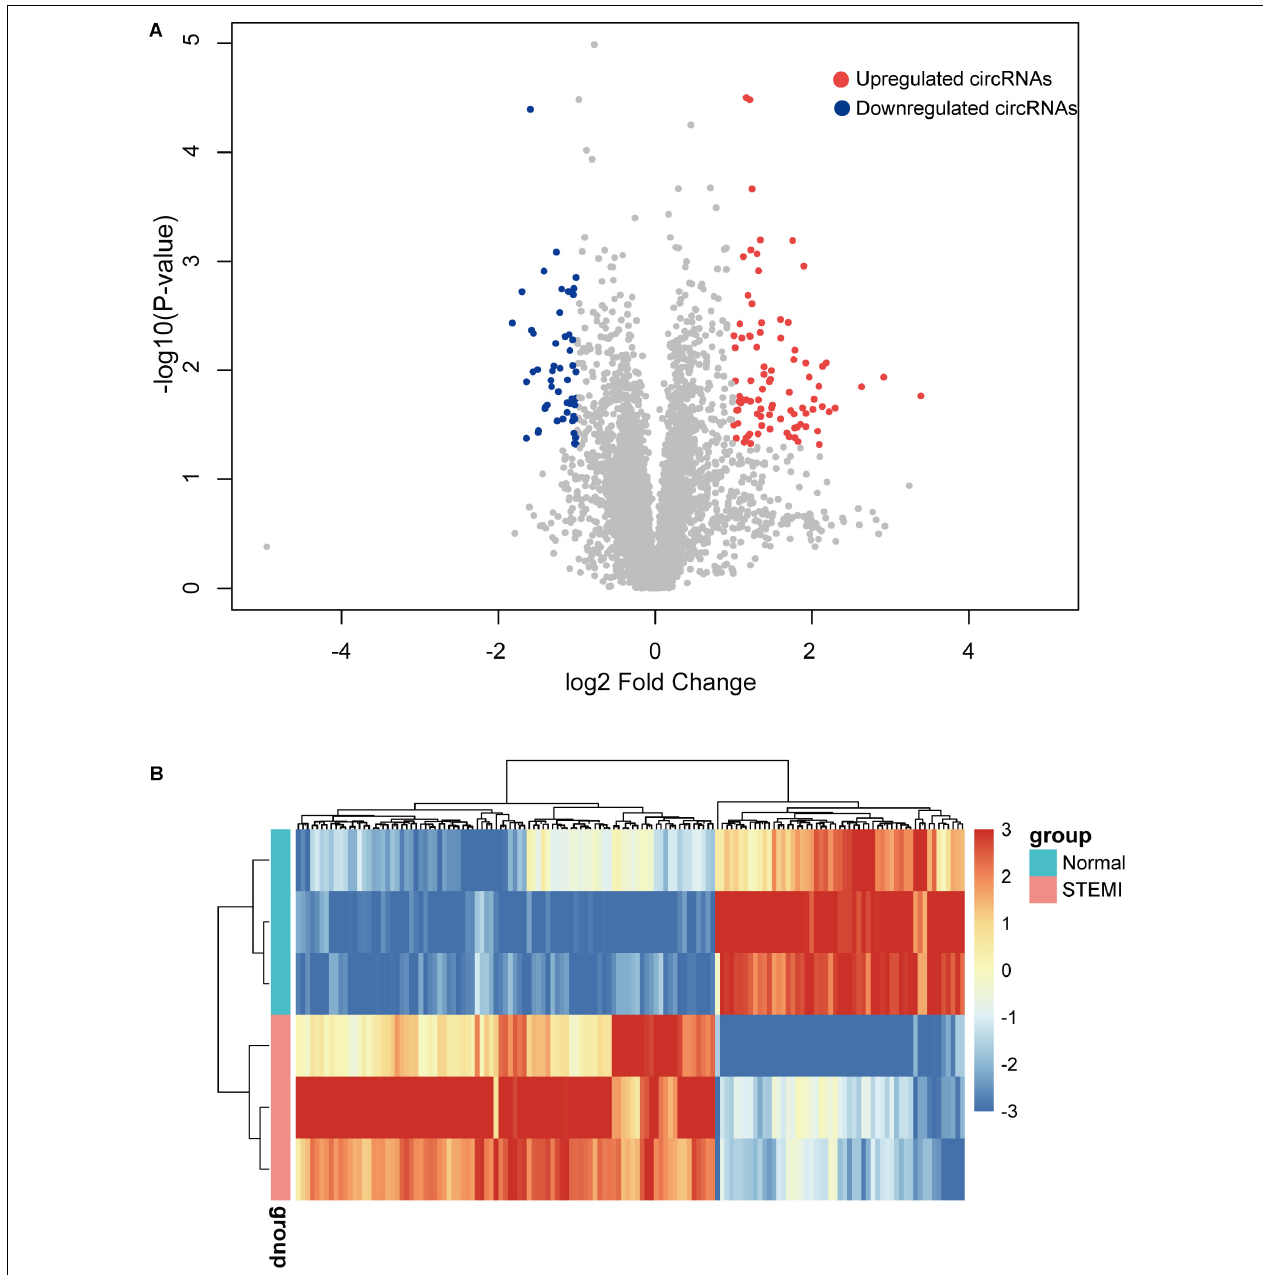
FIGURE 2 | Differentially expressed circRNAs between AMI patients and controls. (A) The volcano plot of 142 circRNAs with a significant difference between groups. (B) Heatmap of dysregulated circRNAs by hierarchical clustering. N = 3, P < 0.05. ctrl, normal control (the same below).